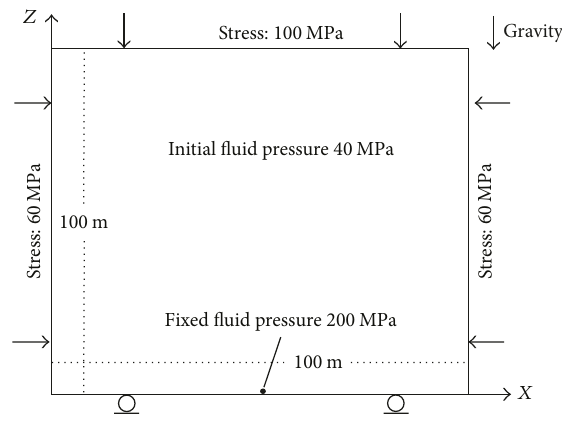
Figure 2: The 2D geometric model in the numerical experiments. The model has a size of 100 m × 100m. 𝑥 -axis represents the orientation normal to veins and 𝑧 -axis is vertical. How the stress and pressure conditions are operated is shown in Section 3.3.